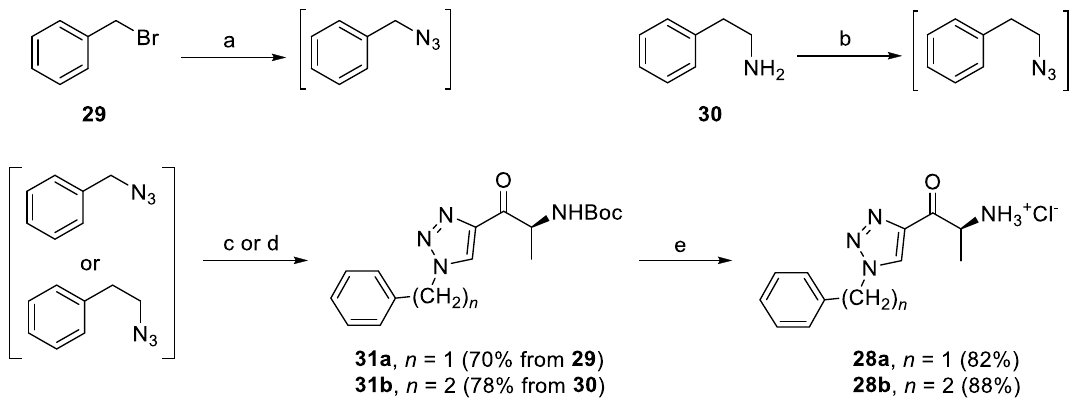
Figure 9. Synthesis of triazole derivatives with variation of the alkyl linker. Reagents and conditions: (a) NaN 3 , acetone/H 2 O, r.t.; (b) ADMP, 4-(dimethylamino)pyridine (DMAP), DCM, 30 °C; (c) 15 , CuSO 4 .5H 2 O, sodium ascorbate, t- BuOH/H 2 O 1:1, r.t.; (d) 15 , CuTC, toluene, r.t.; and (e) AcCl, MeOH, r.t.